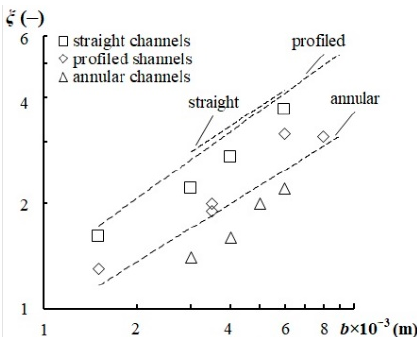
Figure 11. Dependence of the resistance coefficient value on the swirler channel width. Experi- mental data Re = 2200–5000 (1–3): 1—channel width b = 0.0015–0.004 (m); 2— b = 0.0015–0.008 (m); 3— b = 0.003–0.004 (m). Dashed lines: experimental data by Re = 2100–3500.